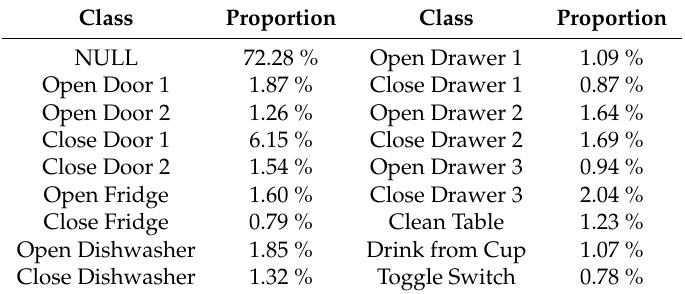
Table 1. Classes of the OPPORTUNITY dataset and their respective proportions of the